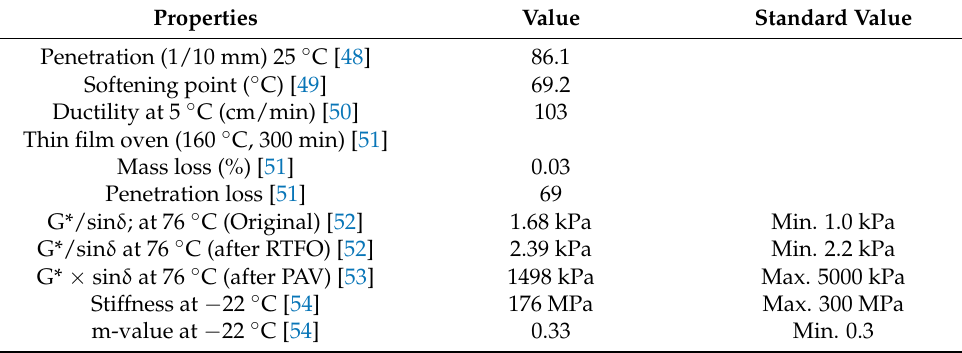
Table 2. Properties of asphalt